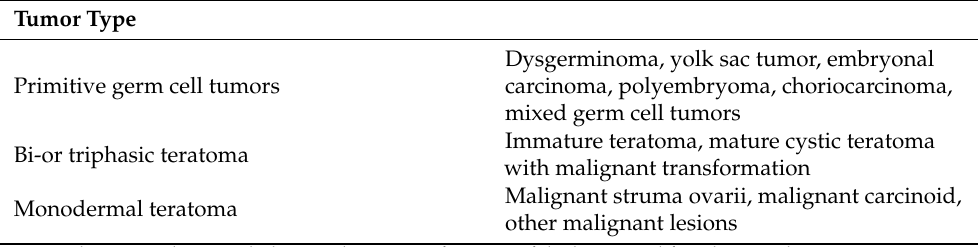
Table 1. Cellular classification of OMGCTs *.